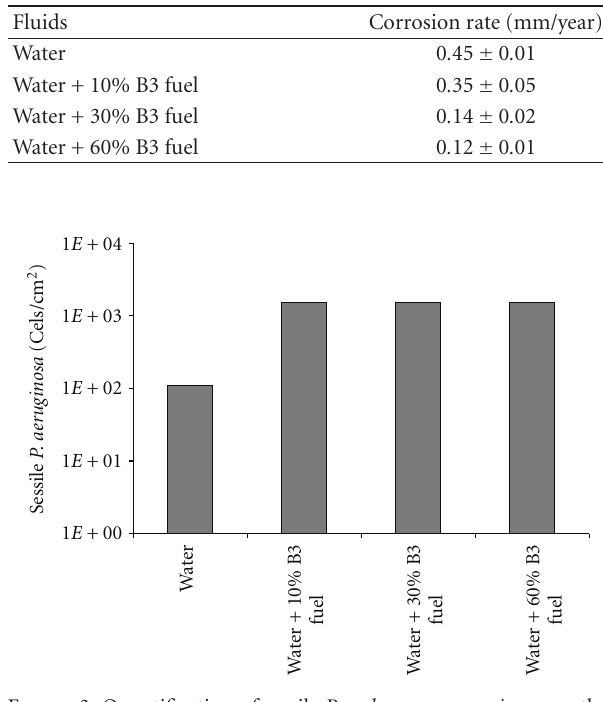
Figure 3: Quantification of sessile Pseudomonas aeruginosa on the AISI-1020 carbon steel after 15 days of experimentation.